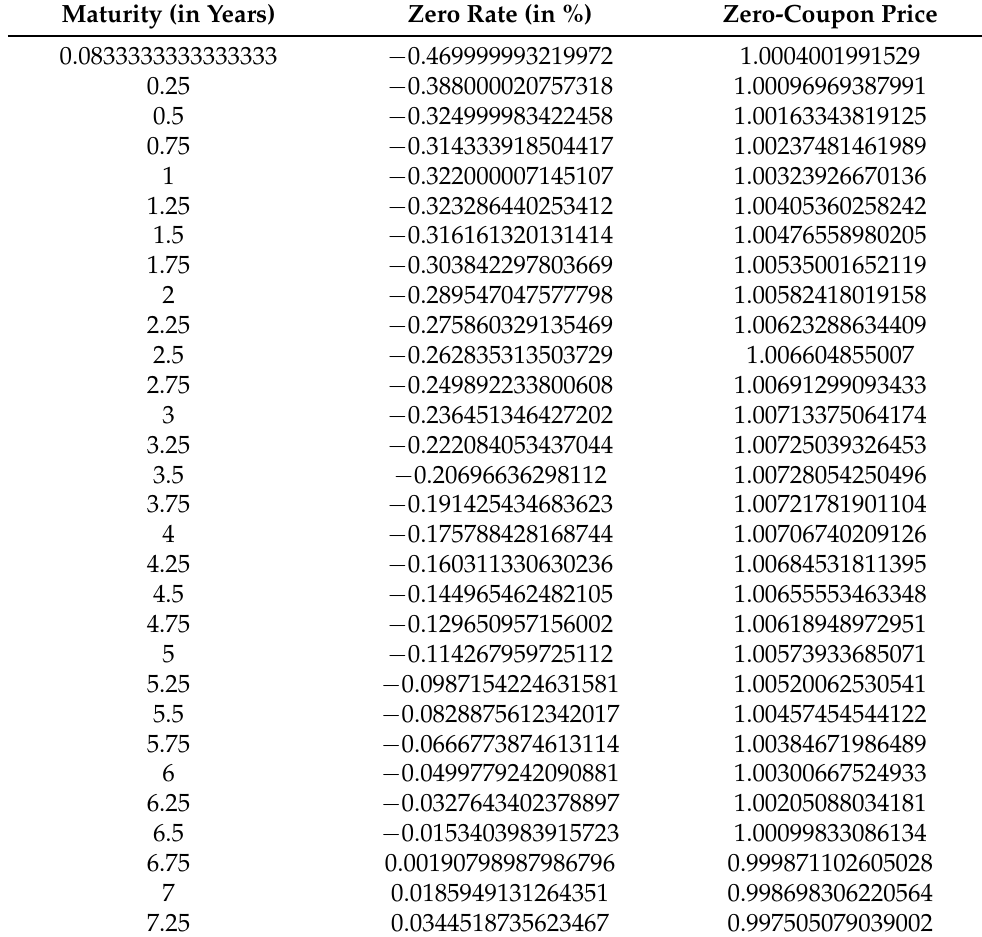
Table A7. Market data containing the zero rate curve and zero coupon curve on 30 December